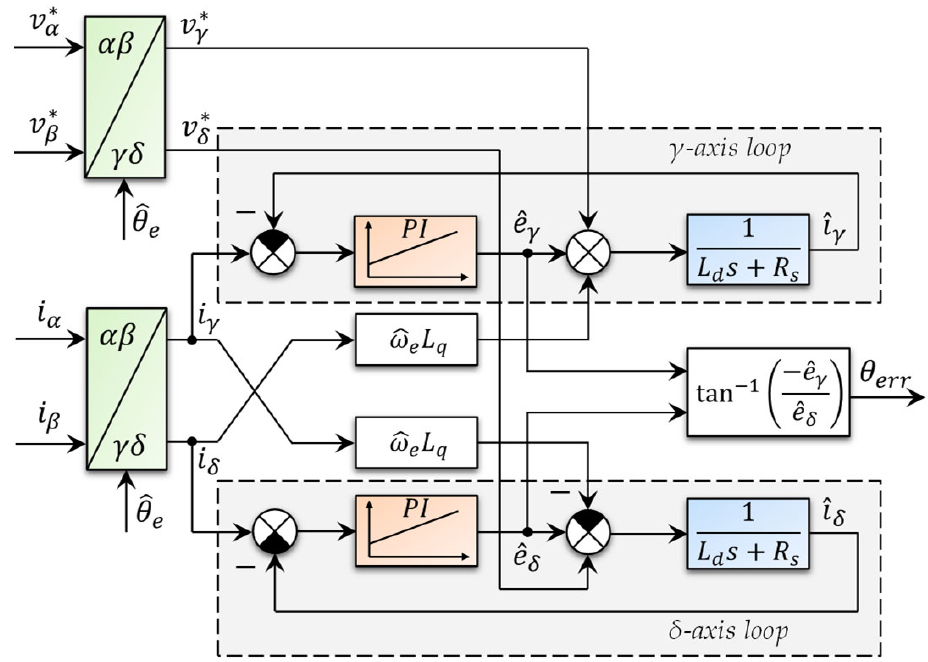
Figure 11. Luenberger ‐ type back ‐ EMF observer in the estimated rotating reference frame γδ .